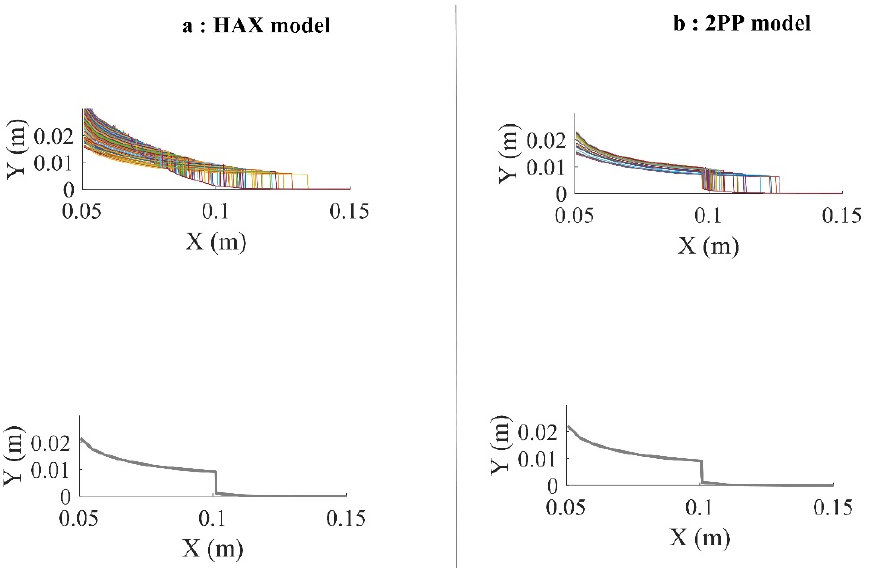
Figure 8. Examples of accretions obtained: ( a ) HAX model and ( b ) 2PP model. Using all 190 (HAX model) or 120 (2PP model) data sets allows for the computing of the NIPCE-predicted PDF of the outputs of interest. The NIPCE allows for an increase in sample size, but the PDF is similar to the PDF predicted, with a sample size of 190 or 120. To verify this for the 2PP model, a sample of 10,000 doublets ( k , k s /k ) was generated with the Latin Hypercube Sampling, and the NIPCE metamodel applied to the sample. The PDFs of the 120 and 10,000 NIPCE predictions are shown together in Figure 9, where the bars’ heights are scaled by the total number of predictions for each case (i.e., 120 and 10,000, respectively).